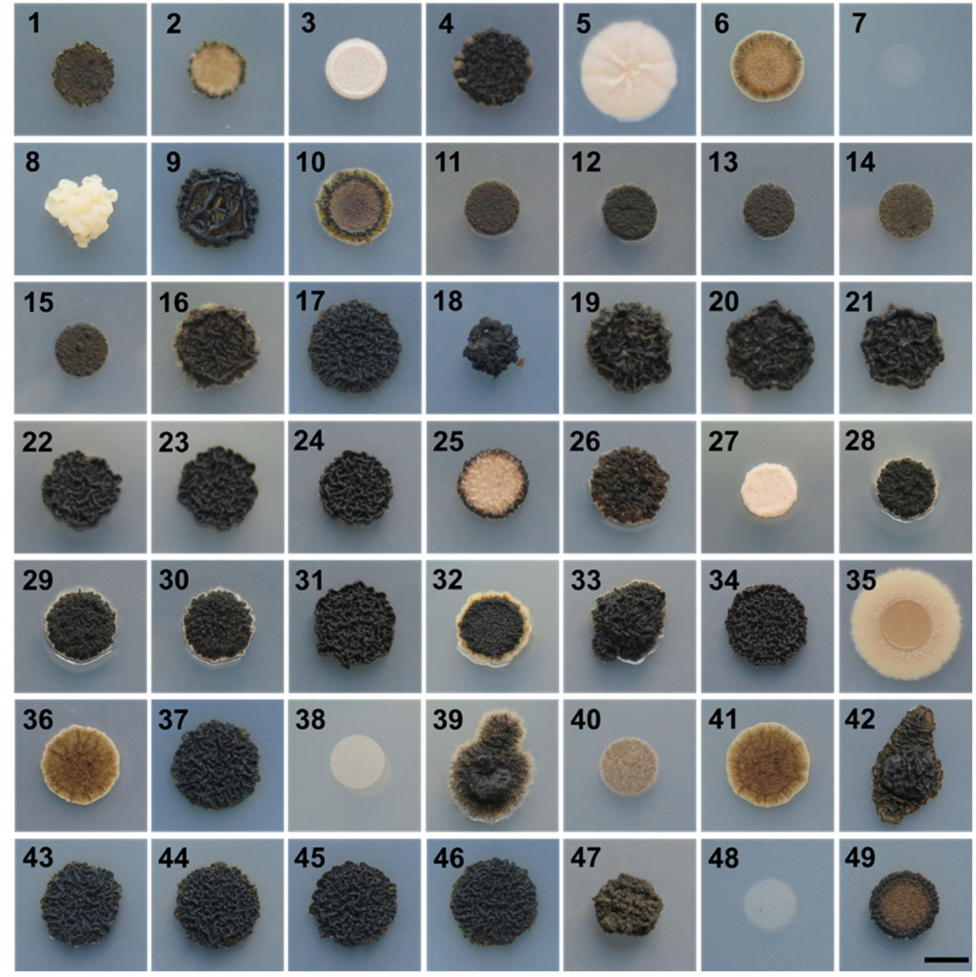
Figure 1. Growth of A. melanogenum strains on YNB medium at 37 ◦ C. Strain numbers (1–49) are listed in Table 1. Scale bar represents 0.5